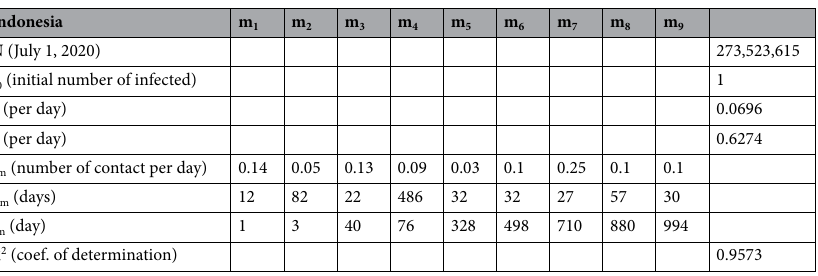
Table 2. Parameter estimation of multiple waves model of COVID-19 for Indonesia (observed data from 15 February 2020 to 11 February